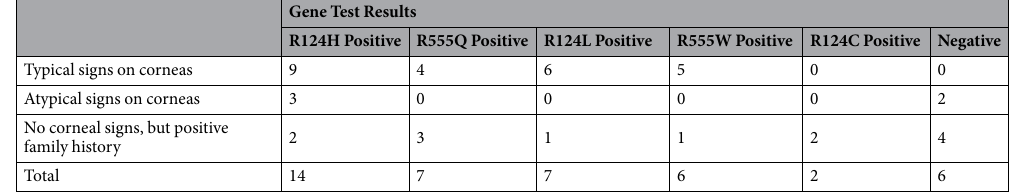
Table 1. Summary of the Gene Test Results. Results of 42 subjects are all shown in Table 1, and the clinical features of subjects are listed in the left